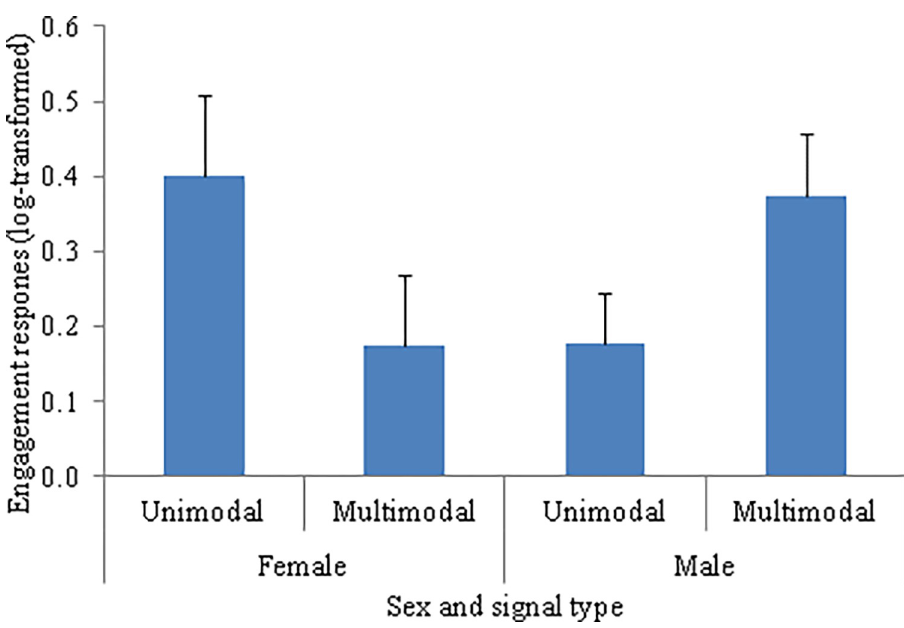
Fig 13. Mean (log-transformed) number of engagement responses to unimodal and multimodal signals. The female and male white-lipped peccaries were displaying submissive behaviors. Error bars denote SE of